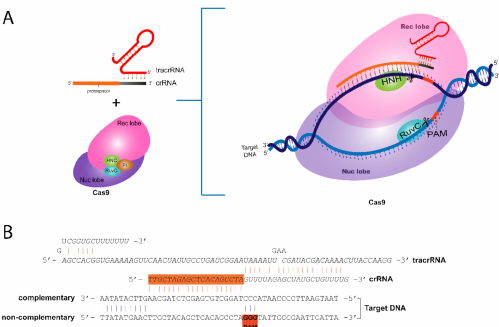
Figure 1. The basic components CRISPR/Cas9 system. ( A ) The crRNA associated with tracrRNA enters Cas9 endonuclease and guides the protein throughout the foreign DNA in search of a full- complementarity region adjacent to a PAM sequence in order to produce the double-strand break. ( B ) Detailed view of interaction of crRNA with the target DNA sequence (complementary sequence) and PAM sequence in the non-complementary strand of